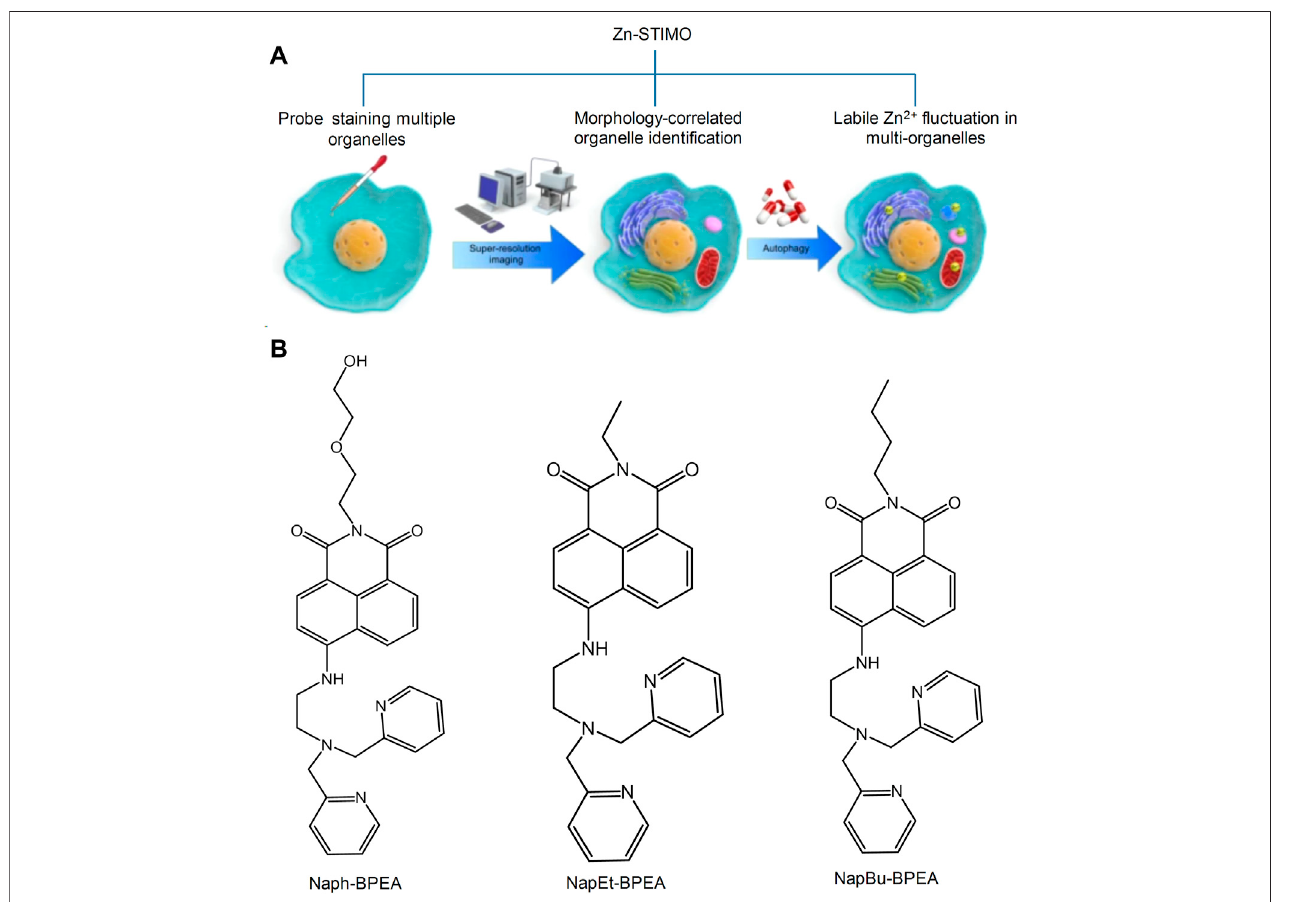
FIGURE 4 | Schematic illustration of Zn-STIMO, and the design of probe candidate for Zn-STIMO (Fang et al., 2021). (A) The scheme of Zn-STIMO; (B) the structure of fl uorescent probes targeting Zn 2+ , Naph-BPEA , NapEt-BPEA , and NapBu-BPEA .